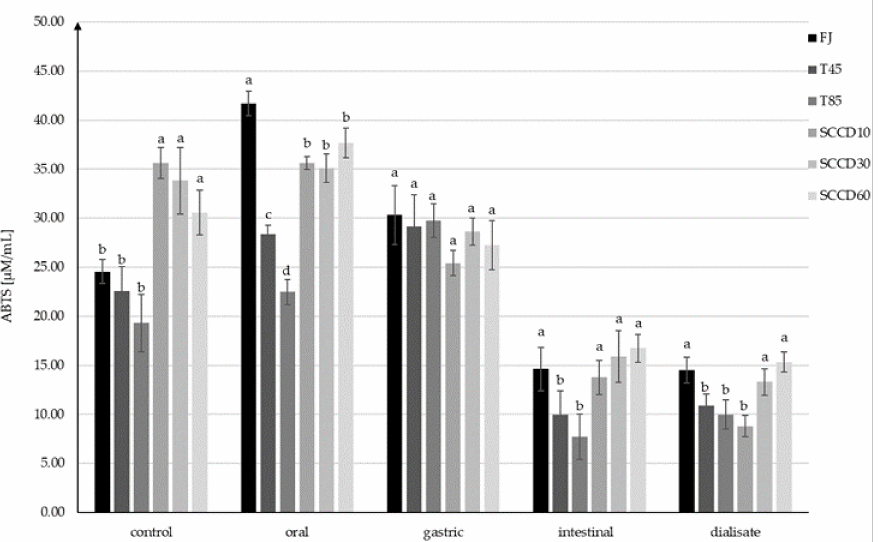
Figure 5. Antioxidant capacity (AC) using the ABTS+ • assay at each step of digestion after different processing: FJ-fresh juice; T45-thermal treated juice at 45 ◦ C; T85-thermal treated juice at 85 ◦ C; SCCD10-juice after super critical carbon dioxide at 10 MPa; SCCD30-juice after super critical